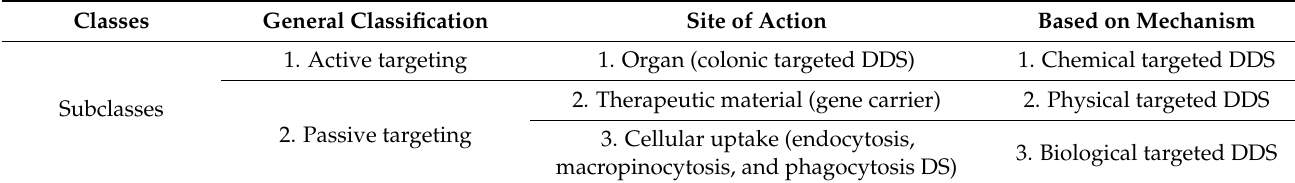
Table 1. Classification of targeted DDSs and their